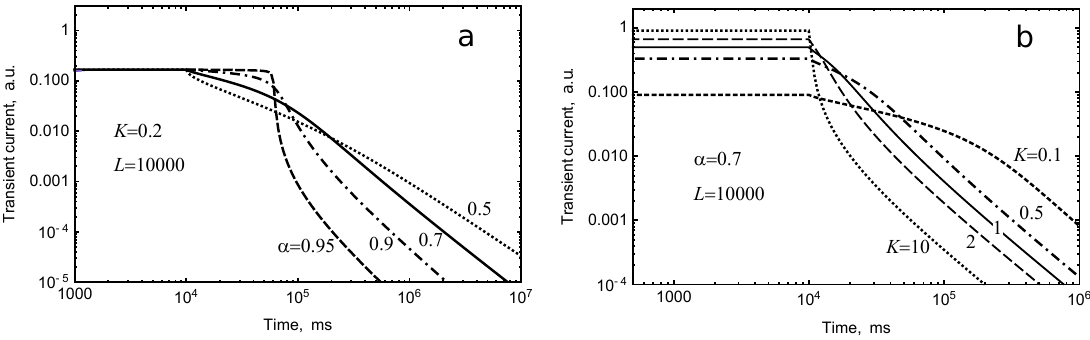
Figure 5. Theoretical transient current curves for various values of 0 < α = β < 1 ( a ) and K ( b ). Other parameters are indicated in